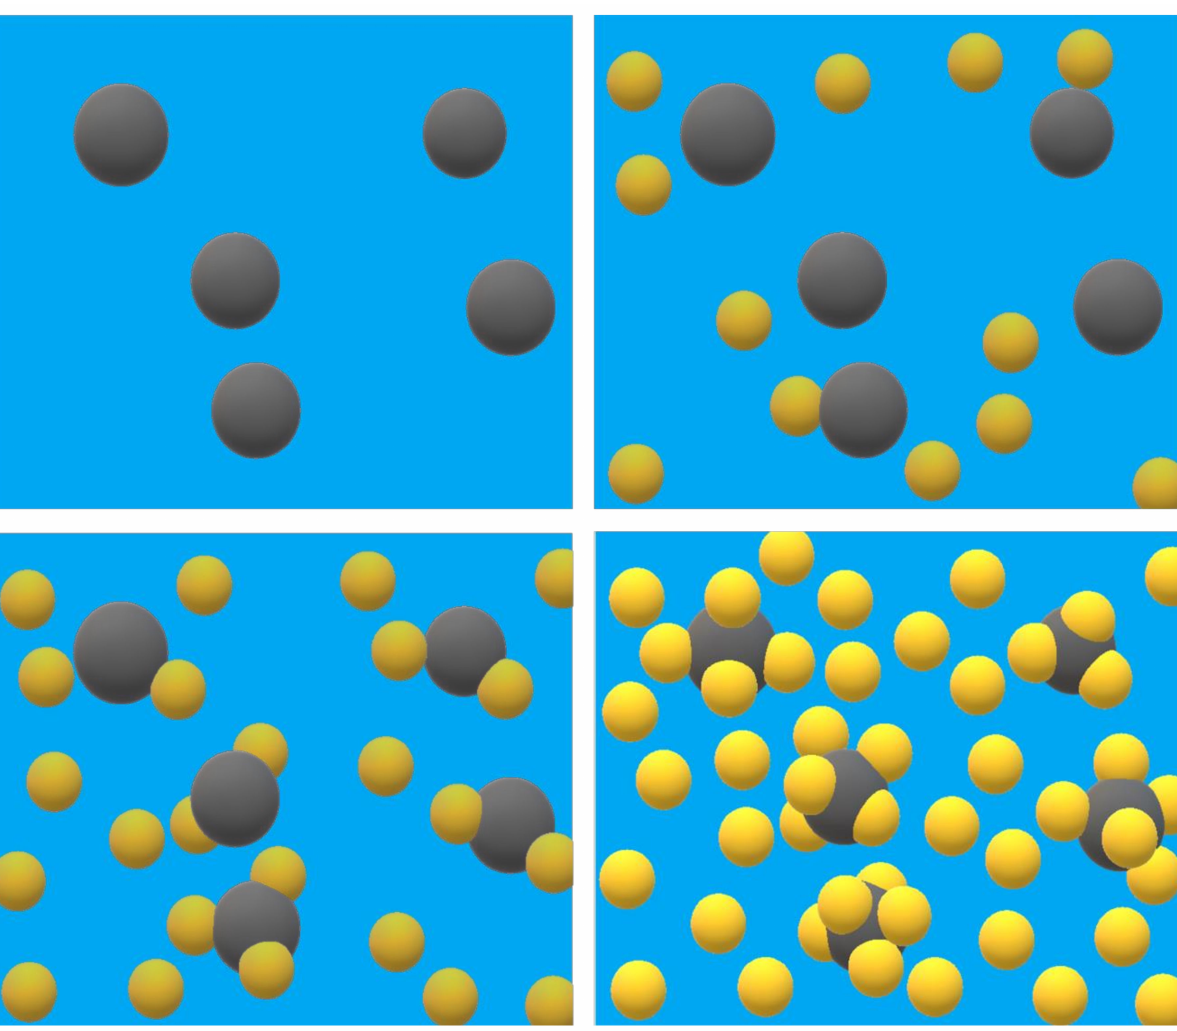
Figure 16. Rubidium (yellow) distribution near platinum (dark gray) on the catalyst surface (blue) depending on the loading: ( top left ) no alkali, ( top right ) low rubidium loading, ( bottom left ) optimal rubidium loading, and ( bottom right ) excessive rubidium